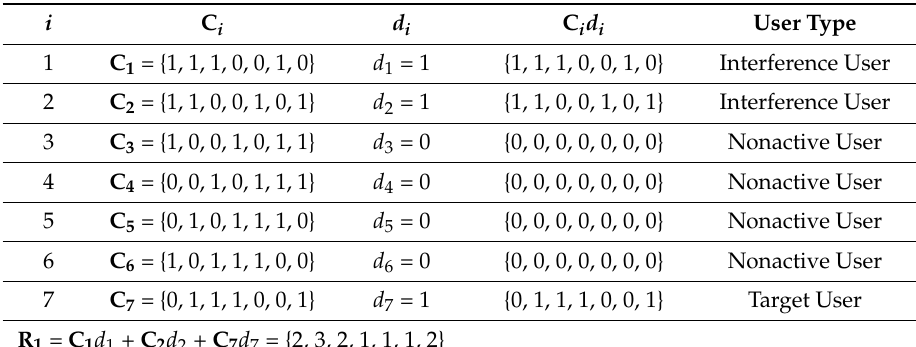
Table 1. A numerical example of data transmissions of optical code-division multiple access (OCDMA) signals for user number K = 7.